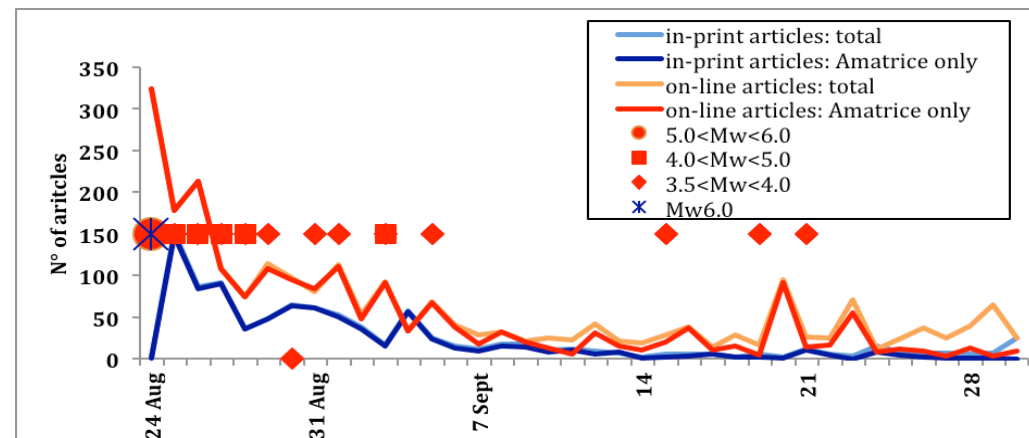
Figure. 1. Impact of the Amatrice sequence in the Media: number of printed and on-line news stories talking about the sequence in one month. The distribution of the M>3.5 earthquakes over time is plotted for